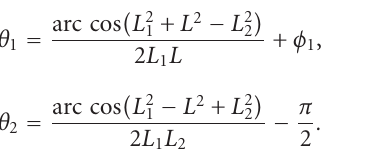
h 0 to show the known elevation of the base over the ground plane allows the end point to be represented as ( D , H - h 0 ) in the two-dimensional space relative to the arm base as opposed to the ground below the arm